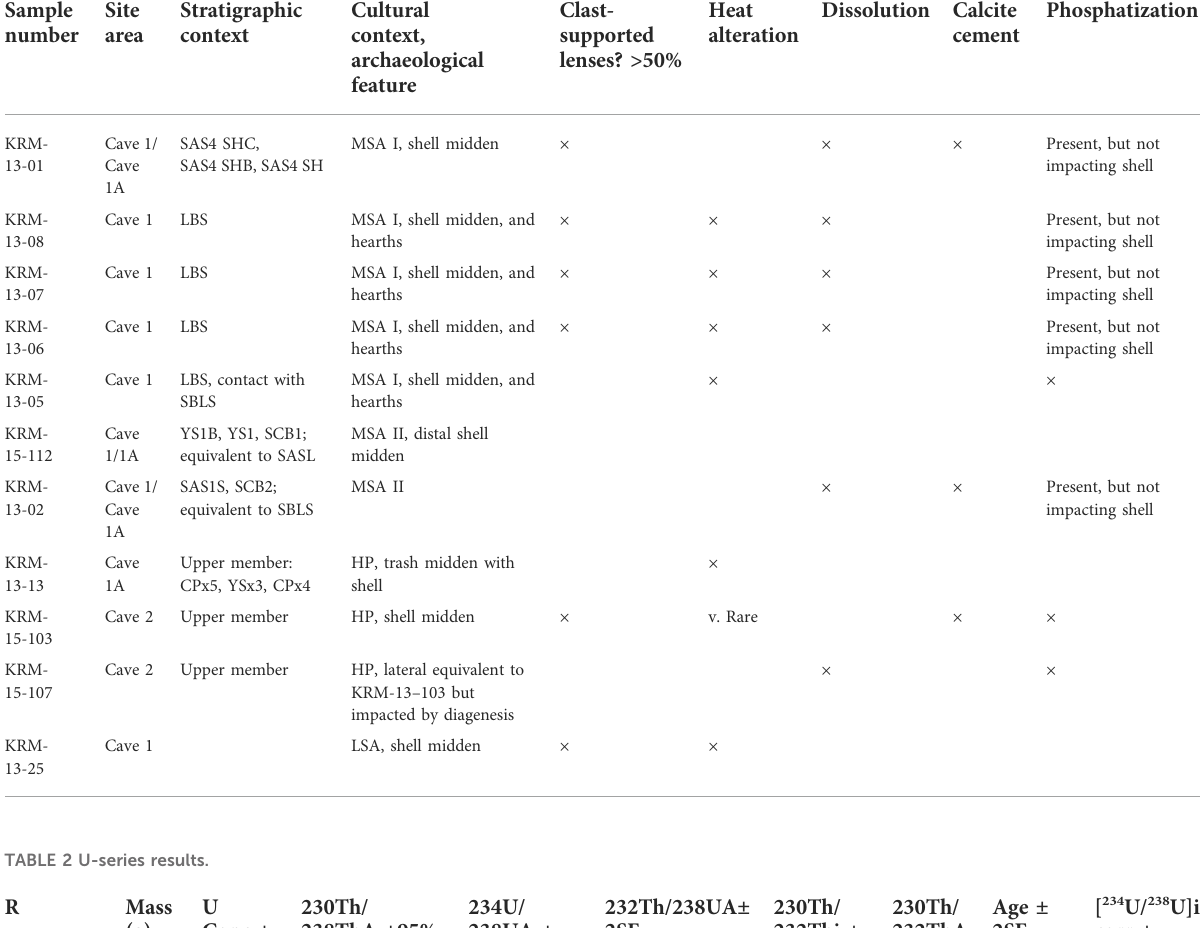
TABLE 1 List of micromorphology blocks referenced in this study and their contexts, with the presence of taphonomic processes that impacted the shell. Sample number